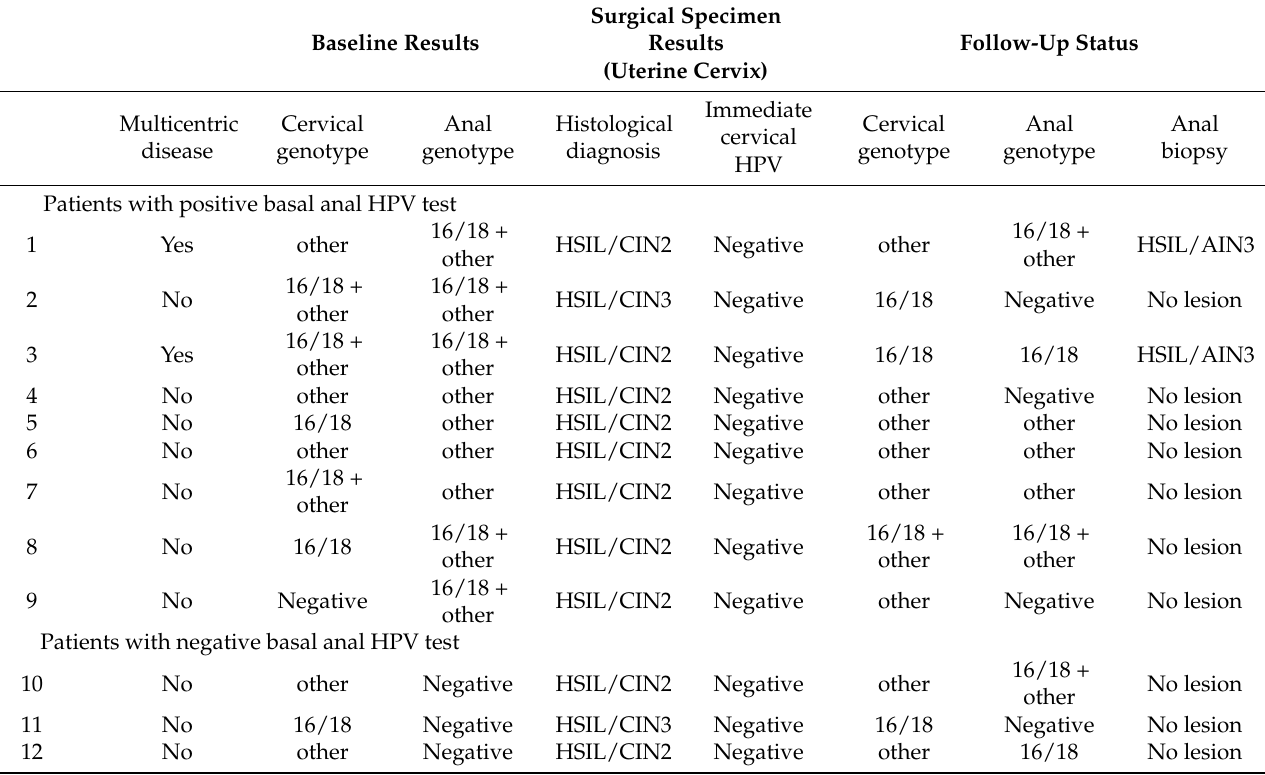
Table 4. Baseline and first follow-up control results of cervical and anal human papillomavirus (HPV) and lesions of the 12 women with negative immediate cervical HPV detection and positive cervical HPV in the first